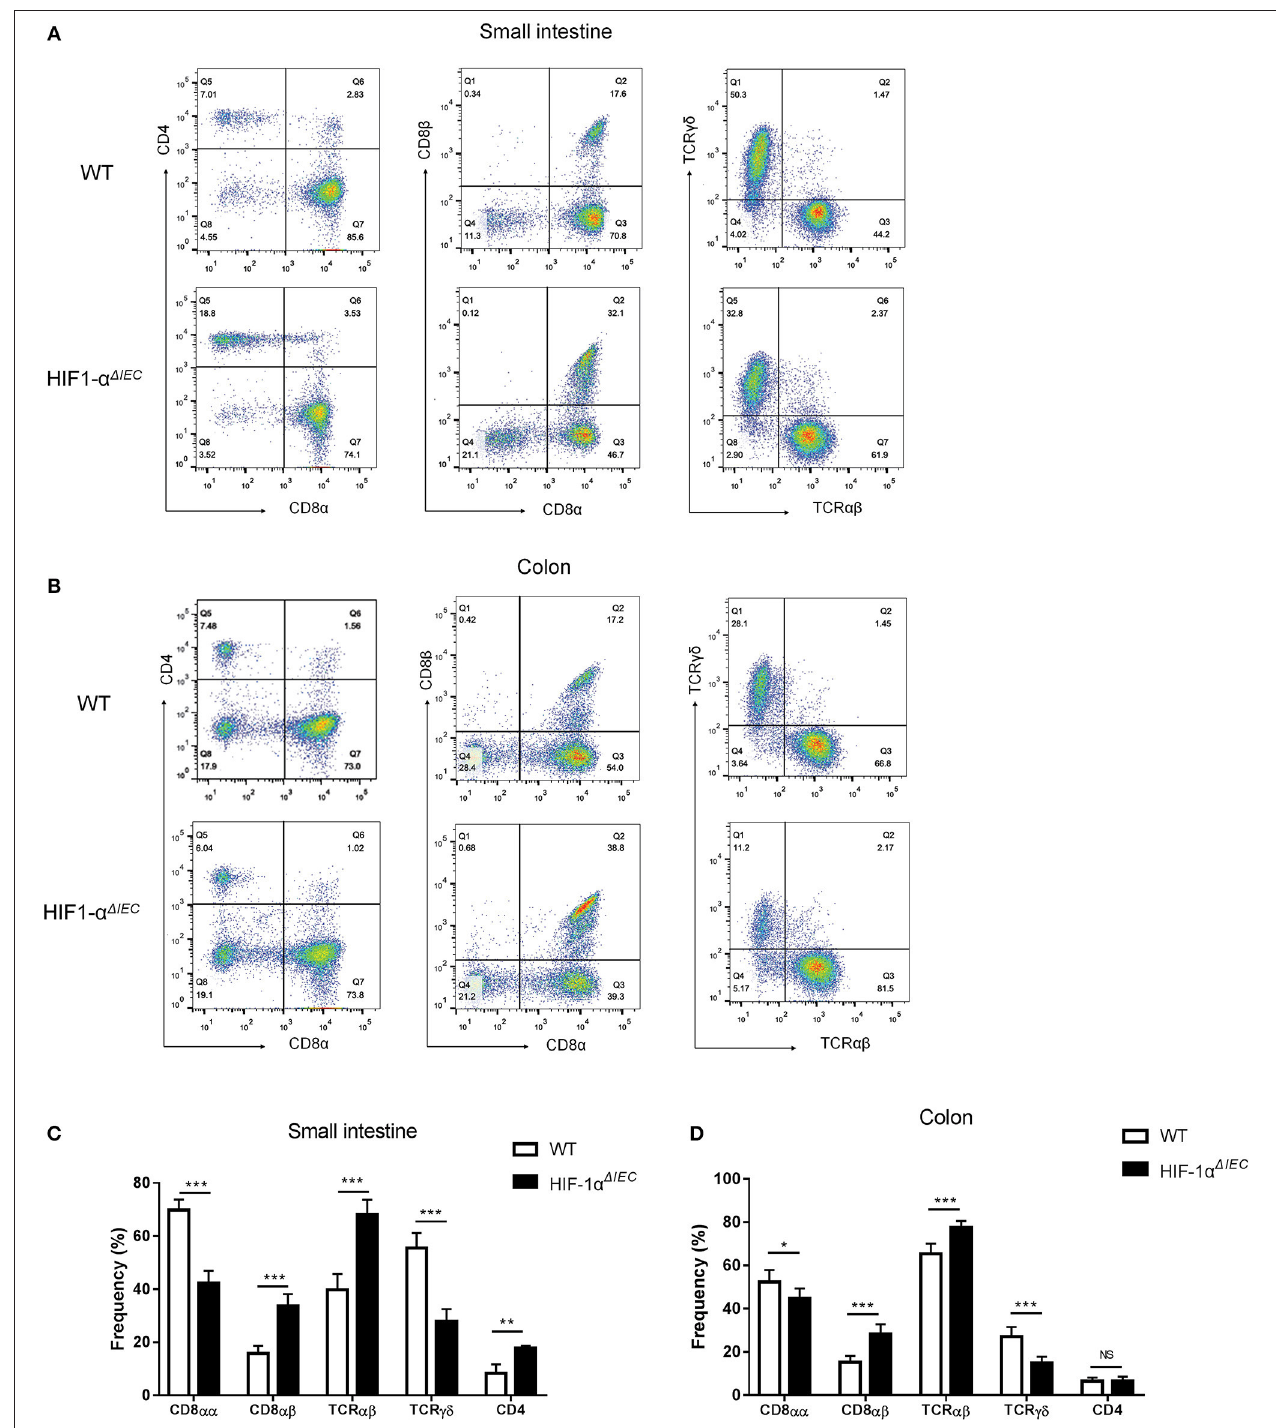
FIGURE 3 | Changes in the phenotypes of intraepithelial lymphocyte (IEL) in Hif1- α ∆ IEC mice. Cell populations are expressed as the percentage of gated cells with different cell phenotype markers. The data were obtained fromCD3-positive cells. The IELs from small intestine (A) or colon (B) of mice were stained as indicated. Expression of CD4, CD8 α , and CD8 β chains on CD3 + IELs. Cells were stained with anti-CD3, anti-CD4, anti-CD8 α , and anti-CD8 β mAbs and positively gated by CD3. Expression of TCR αβ and TCR β on CD3 + IELs. Cells were stained with anti-CD3, anti-CD8 α , anti-TCR αβ , and anti-TCR β mAbs and positively gated by CD3. The proportionality of the indicated IEL subsets in the small intestine (C) or colon (D) of individual mice ( n = 5–7 mice/group). * P < 0.05; ** P < 0.01; *** P < 0.001; NS, not significant.